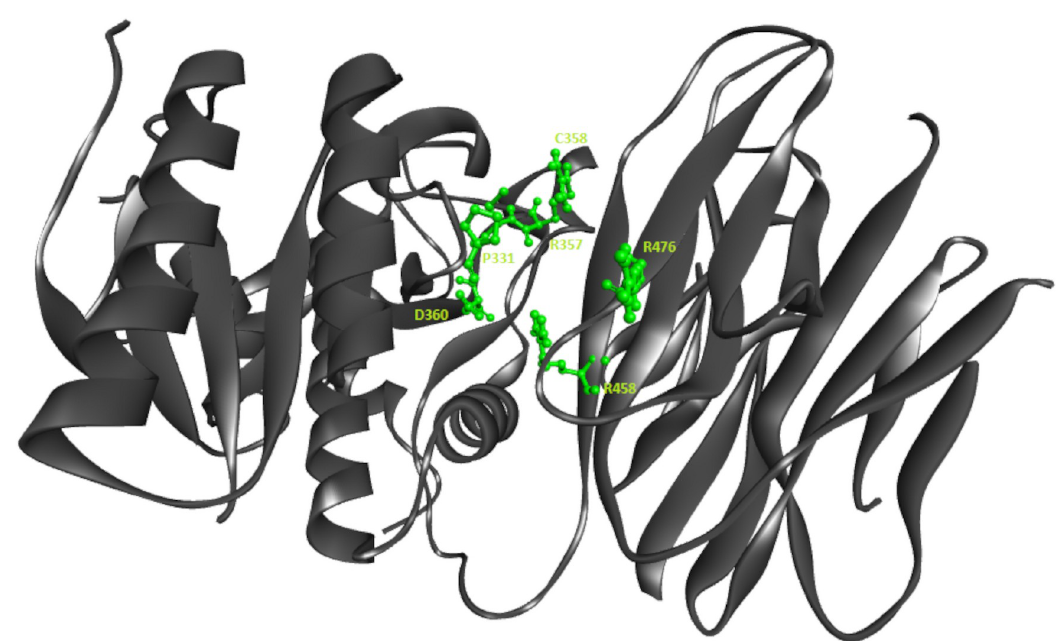
Fig 2. Image showing the active site pocket residues in ball and stick